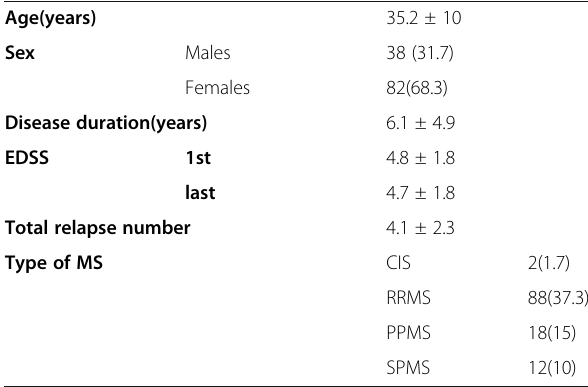
Table 1 Demographics and clinical characteristics of multiple sclerosis